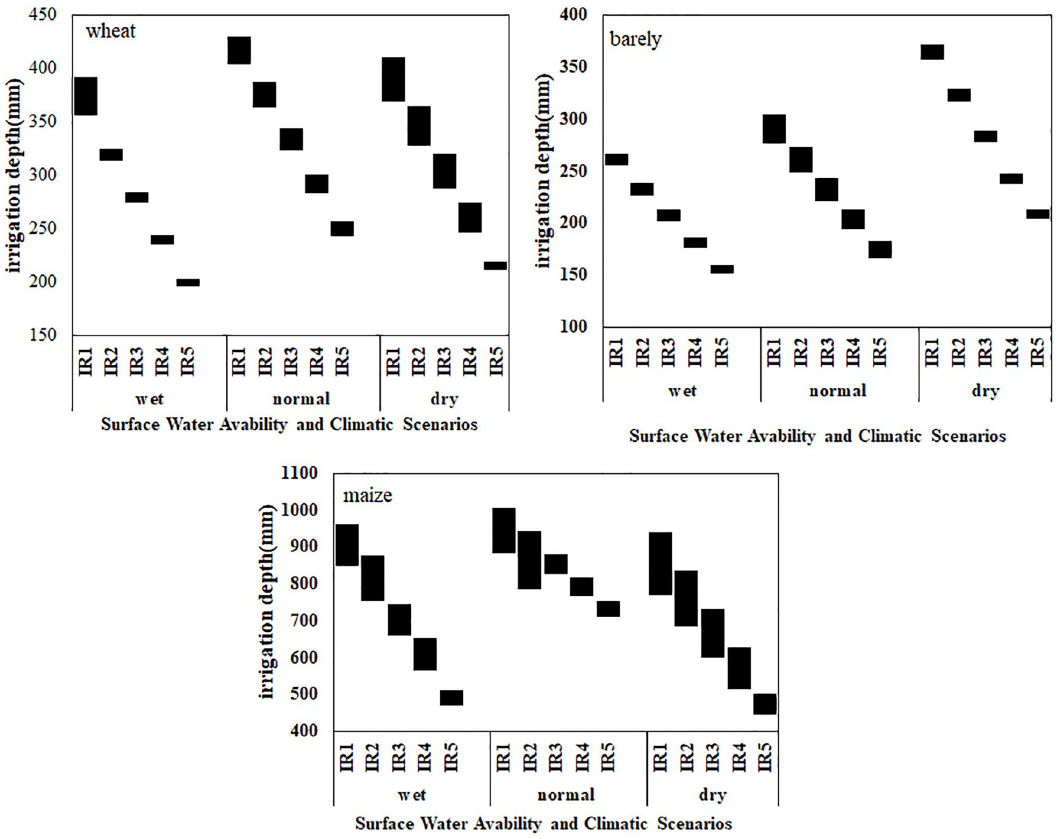
Fig 5. Optimal total irrigation depth for each crop at different surface water availability levels (IR1: No water stress, IR2: 10% water stress, IR3: 20% water stress, IR4: 30% water stress, IR5: 40% water stress) under different climatic conditions.